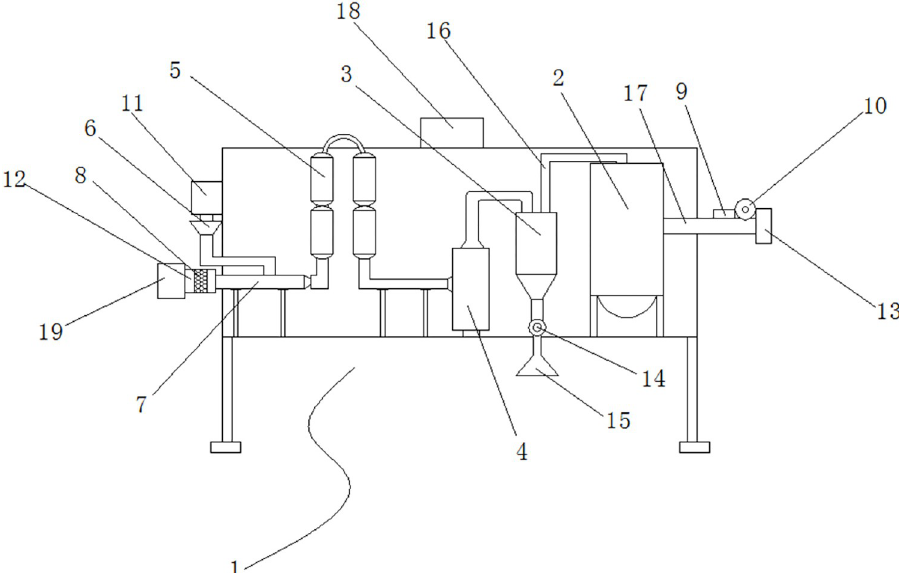
Fig 1. Impulse-cyclone dryer. 1. Intallation body; 2. Impulse bag filter; 3.Cyclone separator; 4. Cyclone dryer; 5. Impulse dryer; 6. Helical feeder; 7. Air inlet pipe; 8. Air filter; 9. Air regulating valve; 10. Fan; 11. Feed port; 12. Air inlet port; 13. Exhaust port; 14. Closed air discharger; 15. Discharge port; 16. Branch pipe; 17. Exhaust pipe; 18. PCL controller; 19.